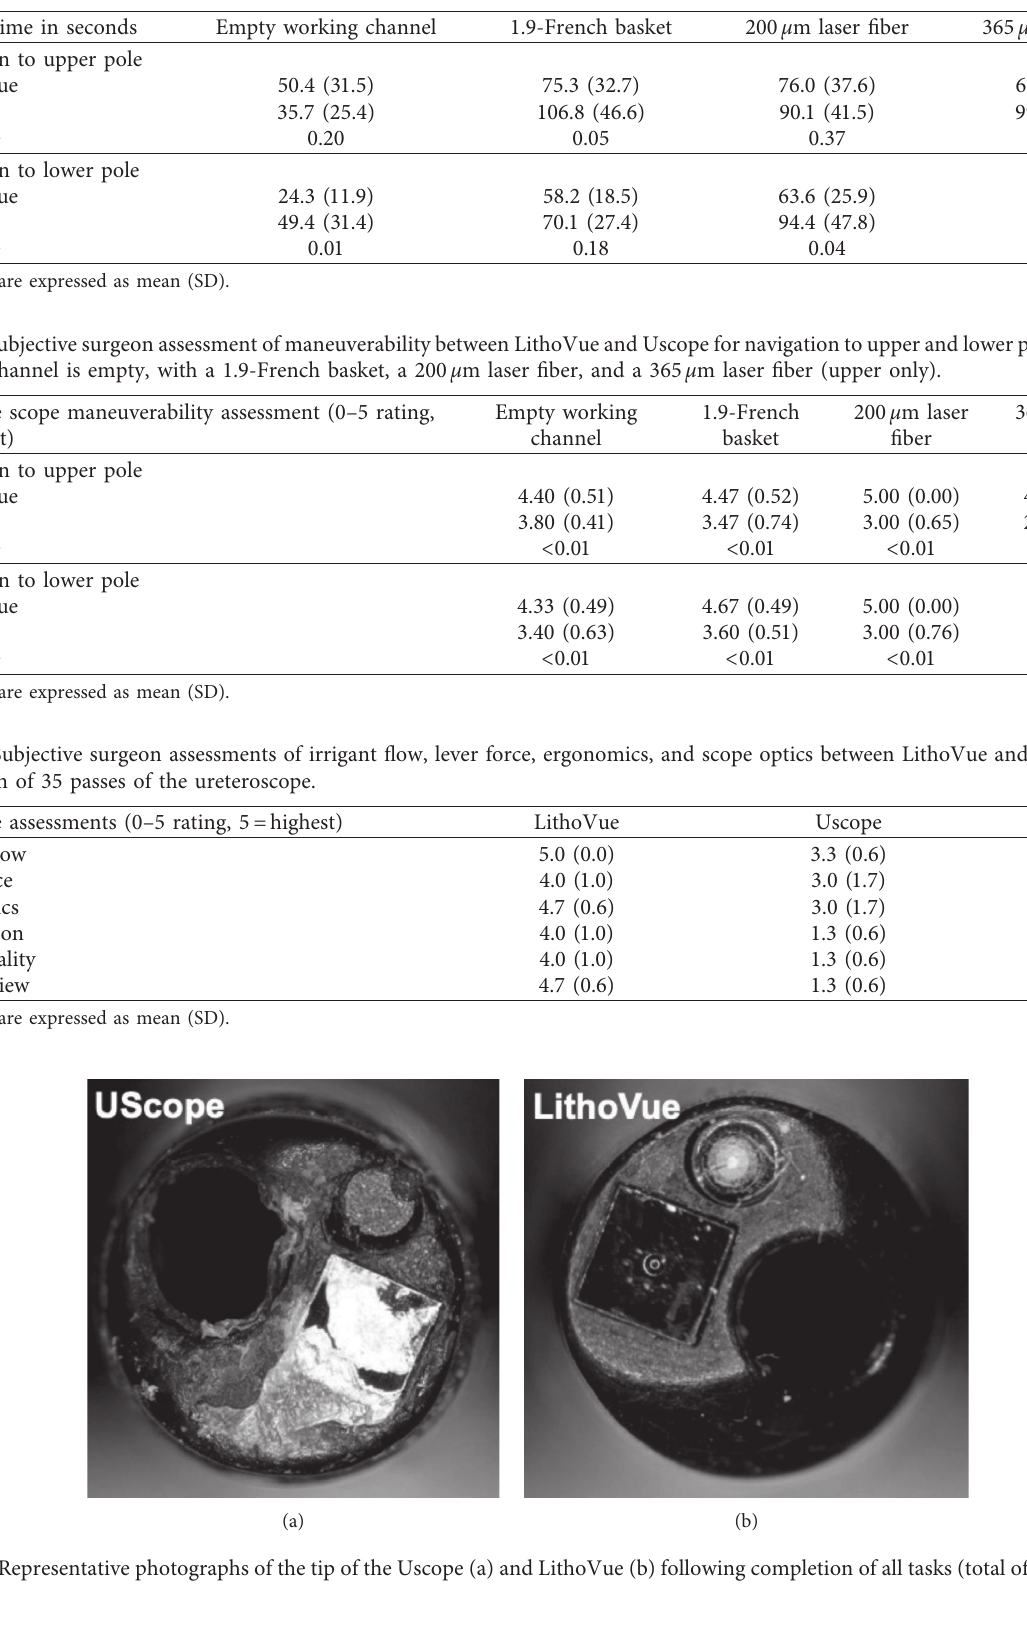
Table 1: Surgeon times (seconds) for navigation to upper and lower poles between LithoVue and Uscope when the working channel is